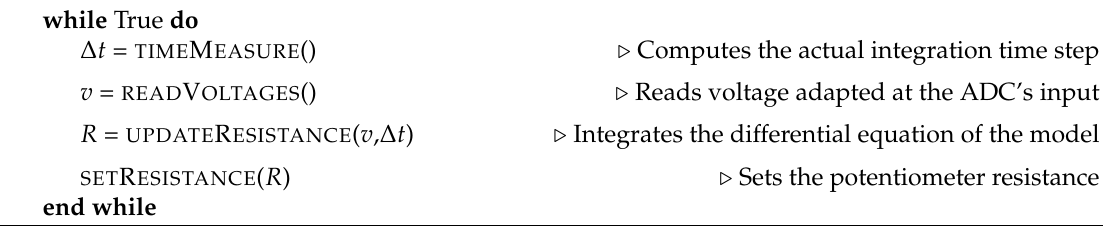
Algorithm 1 Model implementation in Arduino Due: Main loop